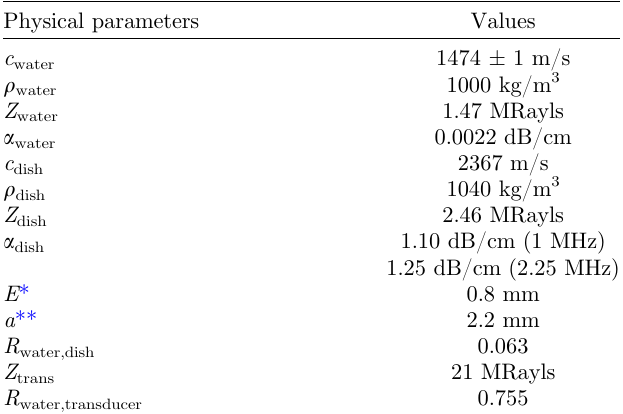
* The bottom thickness of the Petri dish. ** The distance between the bottom of the Petri dish and the hydrophone tip